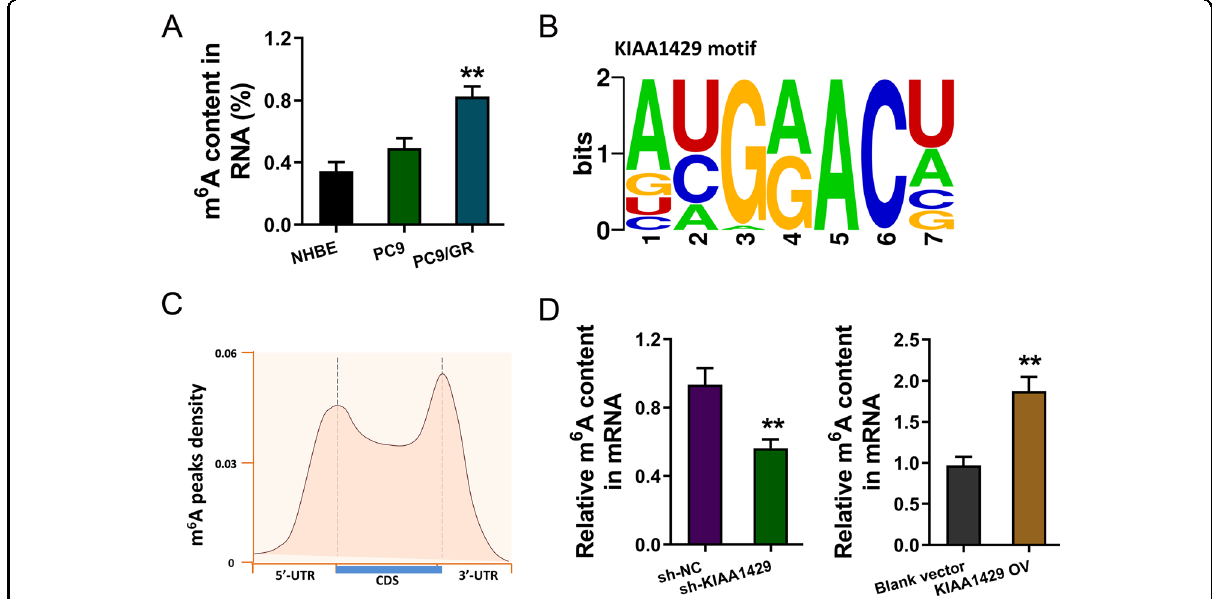
Fig. 3 MeRIP-Seq revealed the m 6 A pro fi le in ge fi tinib-resistant NSCLC cells. A m 6 A quantitative analysis was carried out to illustrate m 6 A enrichment in the ge fi tinib-resistant cells (PC9-GR) and parental cells (PC9). B The motif of KIAA1429 was identi fi ed (AUGGACU) according to MeRIP- Seq. C Metagene pro fi le of m 6 A distribution across transcriptome was detected by this MeRIP-Seq. D m 6 A quantitative analysis was measured in PC9- GR cells with KIAA1429 knockdown and KIAA1429 overexpression transfection. Bar graphs indicate the means ± SD. ** P <